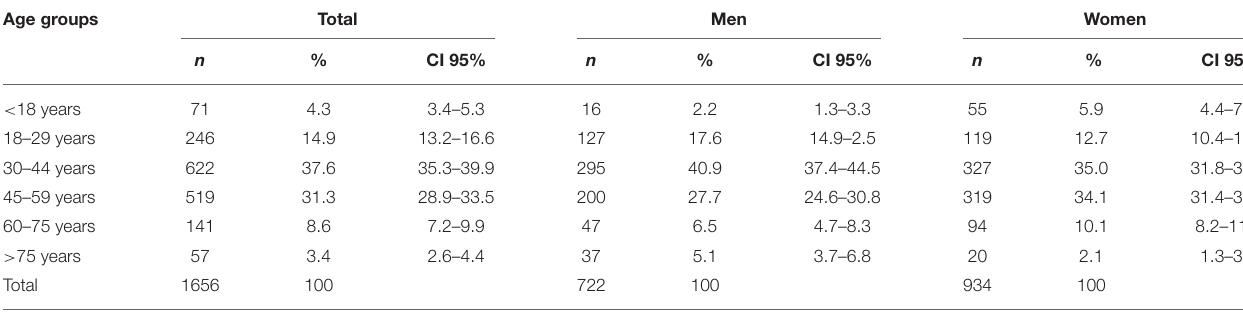
Missing data n = 72.